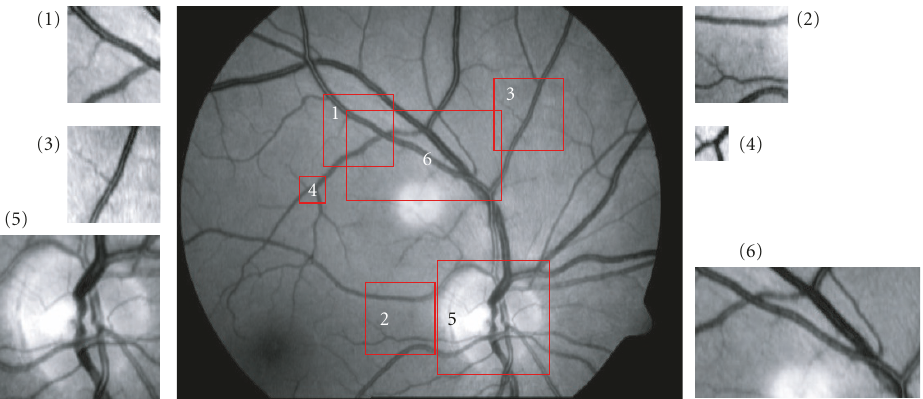
Figure 2: Example of retinal fundus image with the selected templates: (1)–(3) medium template (100 × 100 pixels); (4) small template (40 × 40pixels); (5) large template which includes the optic nerve (180 × 180 pixels); (6) large template (240 × 140 pixels).